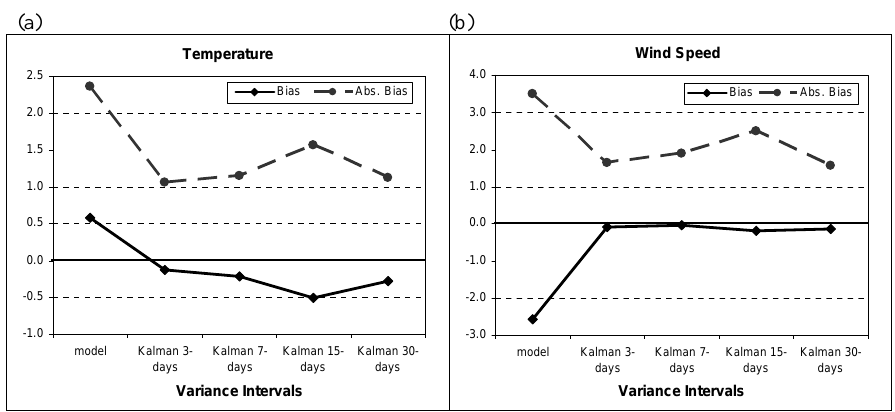
Fig. 1. Bias and Absolute Bias of direct model outputs and Kalman filtered results for (a) temperature and (b) wind speed, based on different time intervals for the estimation of variance matrices (3, 7, 15 and 30 days)